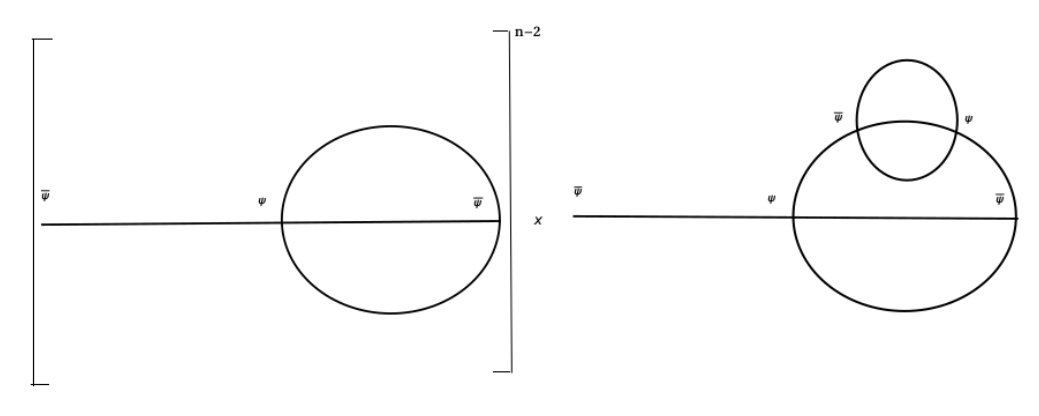
Figure 8 . Parts of subleading